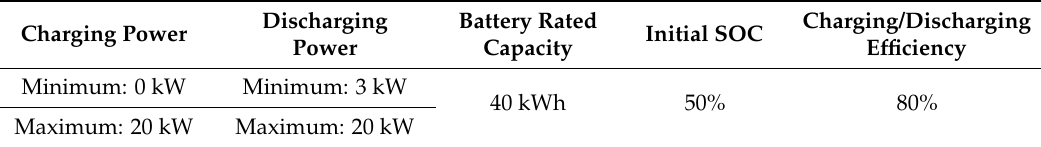
Table 1. Specifications of energy storage system (ESS) (SOC: state of